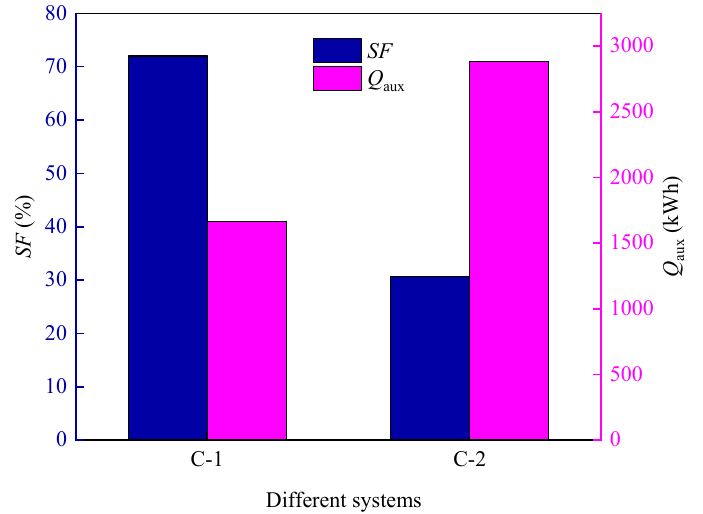
Figure 10. Comparison of solar fraction and auxiliary energy consumption of different systems operating continuously for the whole refrigeration season.